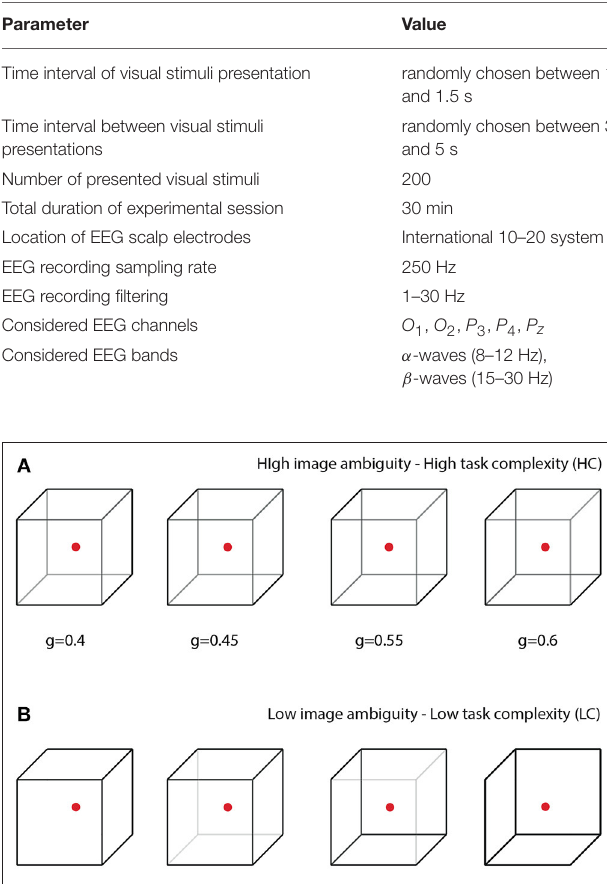
TABLE 1 | Parameters of the experiment.